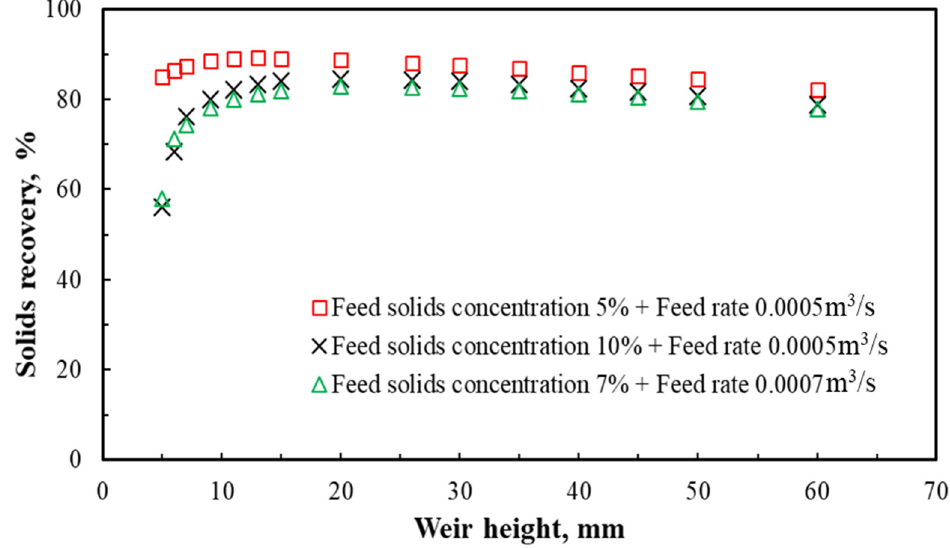
Figure 8. The relationship between the weir height and solids recovery, with different solids load- ings.